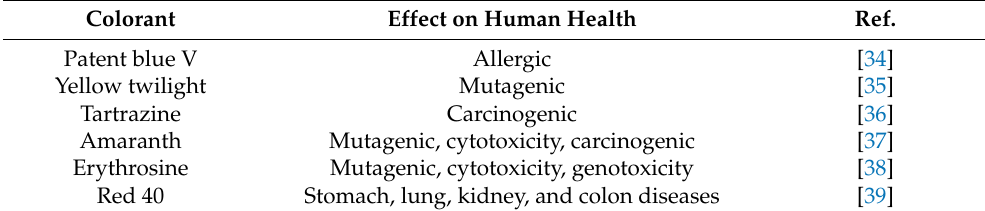
Table 1. Scientific reports on the toxicity of synthetic colorant adapted by Castro , et al. [33] . Colorant Effect on Human Health Ref. Patent blue V Allergic Yellow twilight Mutagenic Tartrazine Amaranth Erythrosine Mutagenic, cytotoxicity, genotoxicity Red 40